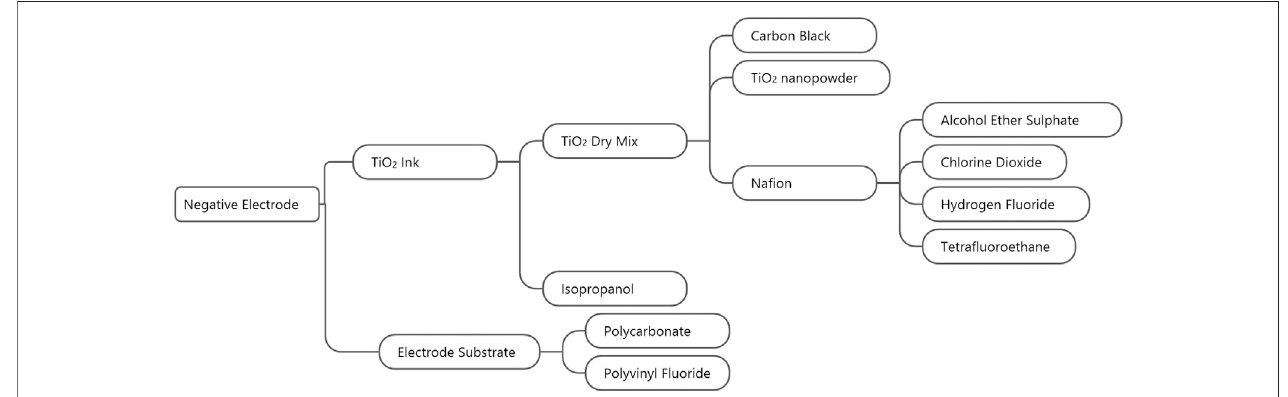
FIGURE 5 | Production fl ow for the negative electrode redrawn from OpenLCA.